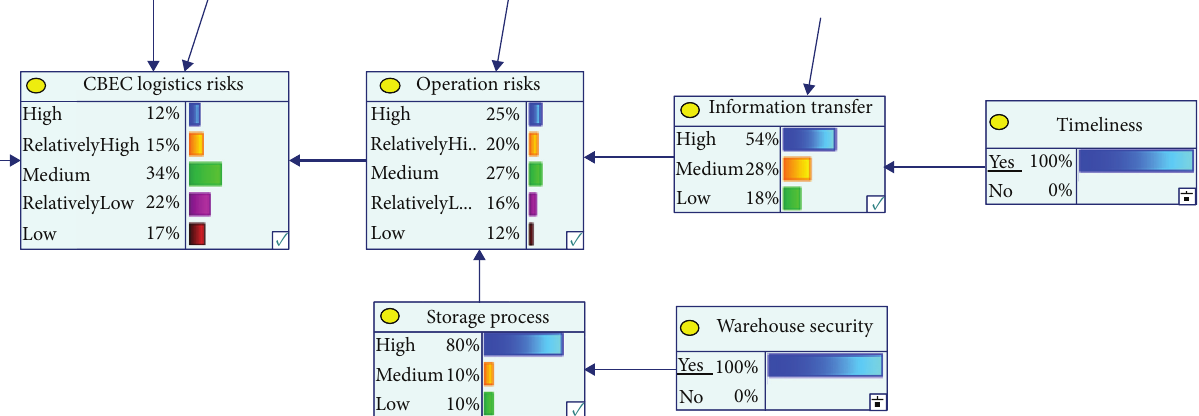
Figure 5: After the operation risk.